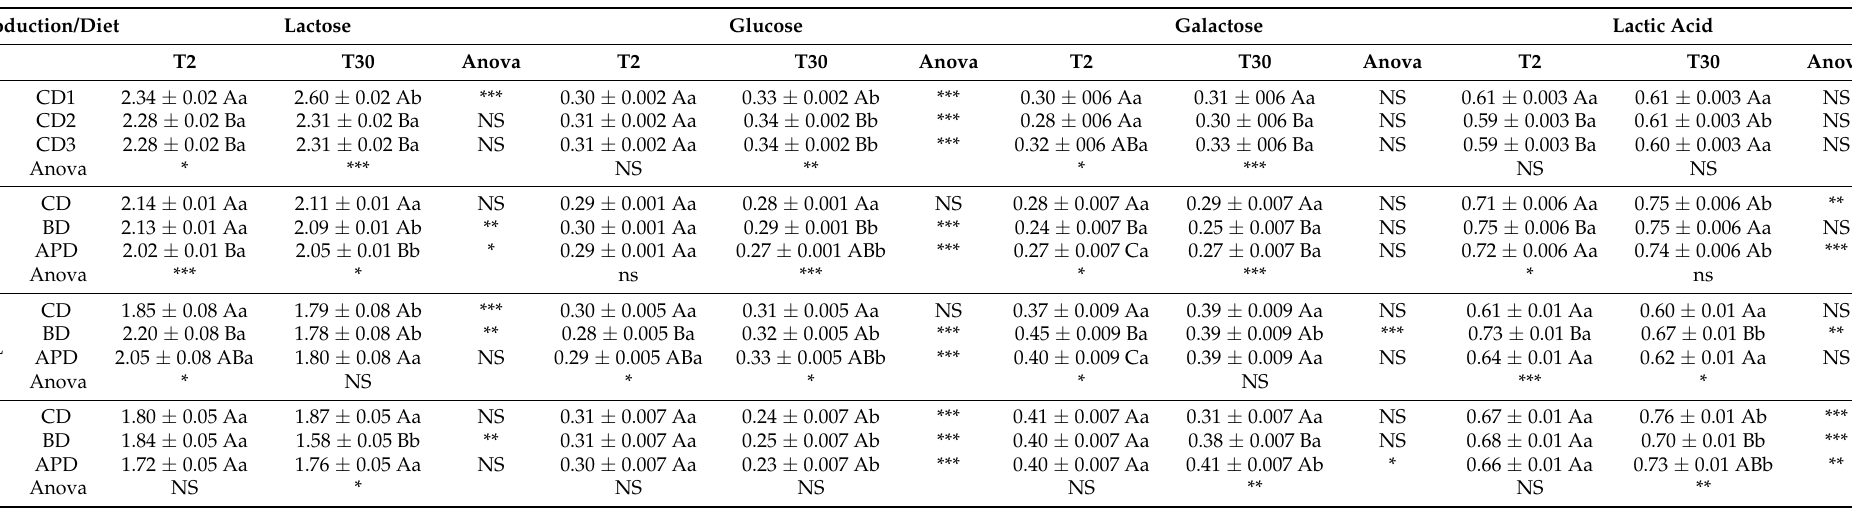
Table 5. Sugars and lactic acid content in fermented milk manufactured and stored for 2 and 30 days with milk from Murciana-Granadinas goats fed differentiated diets, using a mesophilic (MA400) starter